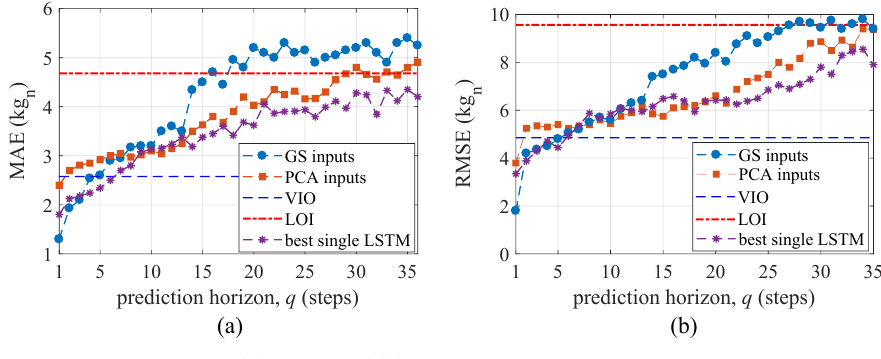
Figure 10. Error metrics ( a ) MAE; and ( b )